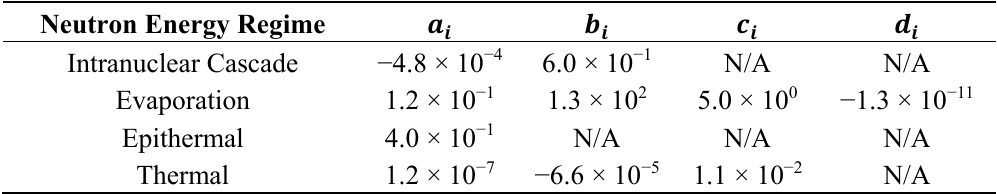
Table 2. Parameters for 𝐶 (𝐸) equations to apportion equivalent dose from neutron energy 𝑖